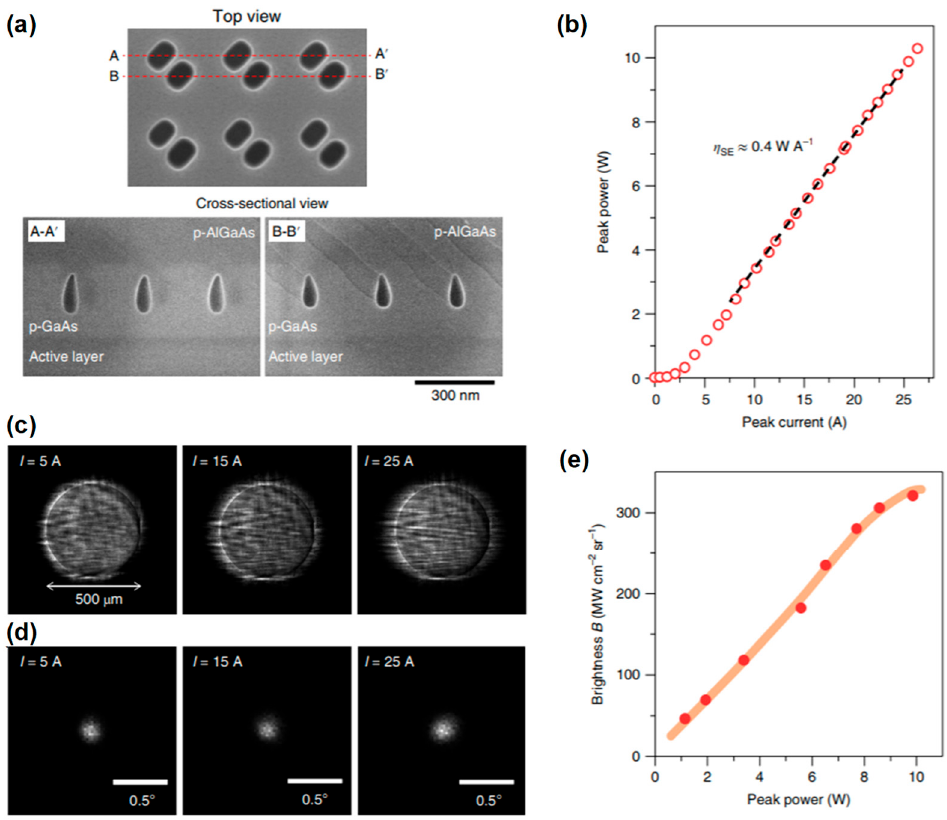
Figure 12. ( a ) Top and cross-sectional SEM images of the fabricated double-lattice photonic crystal using structure II before and after metal–organic vapor phase epitaxy (MOVPE) regrowth. ( b ) Output power as a function of peak injection current. The pulse width and repetition frequency were set to ~200 ns and 200 Hz, respectively. ( c ) Measured near-field pattern (NFP) at different injection currents. ( d ) Measured FFP at different injection currents. ( e ) Laser brightness evaluated using the measured NFP and FFP widths. Reprinted by permission from Springer Nature, Nature Materials [16], 2019.